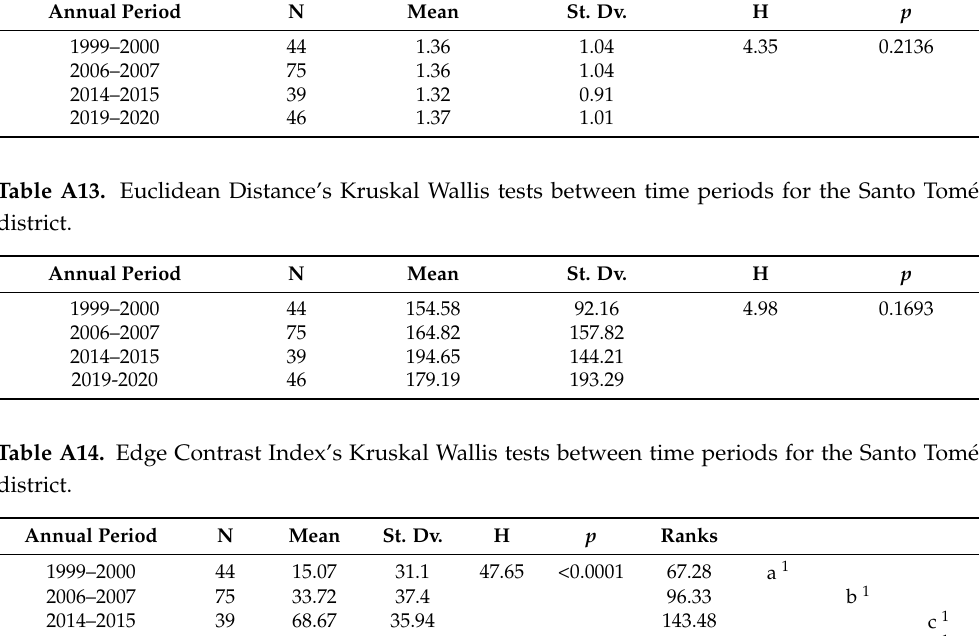
Table A12. Shape Index’s Kruskal Wallis tests between time periods for the Santo Tom é district. Annual Period N Mean St. Dv.